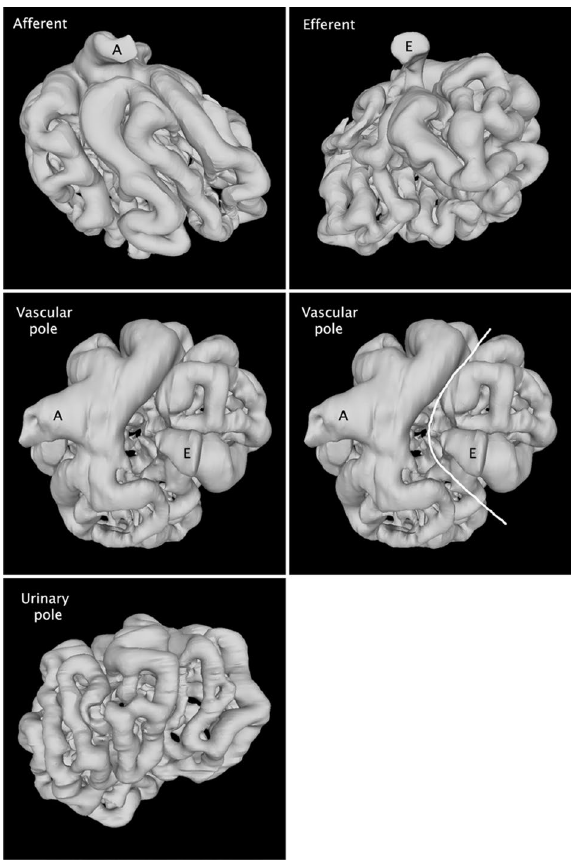
Figure 3. Views from several sides of a reconstructed glomerulus (far left glomerulus in the second row of Fig. 2). The afferent and efferent arterioles are indicated by the letters “A” and “E” respectively. Top row: the afferent arteriole branches (left panel) are noticeably wider than the efferent arteriole branches (right panel). Middle row: view from the vascular pole side, showing the branches from the afferent arteriole and efferent arteriole. The wider afferent arteriole branches are also evident from this view. The white line on the right panel indicates the “no-cross zone” or cleft which separates the afferent branches and efferent branches. If a connection existed here, it would constitute a short cut path which would allow blood to pass through without being filtered. Bottom row: view from the urinary pole shows that the capillary segments are narrower than those on the vascular pole side, which corresponds to the expected lower blood flow rate in these segments.